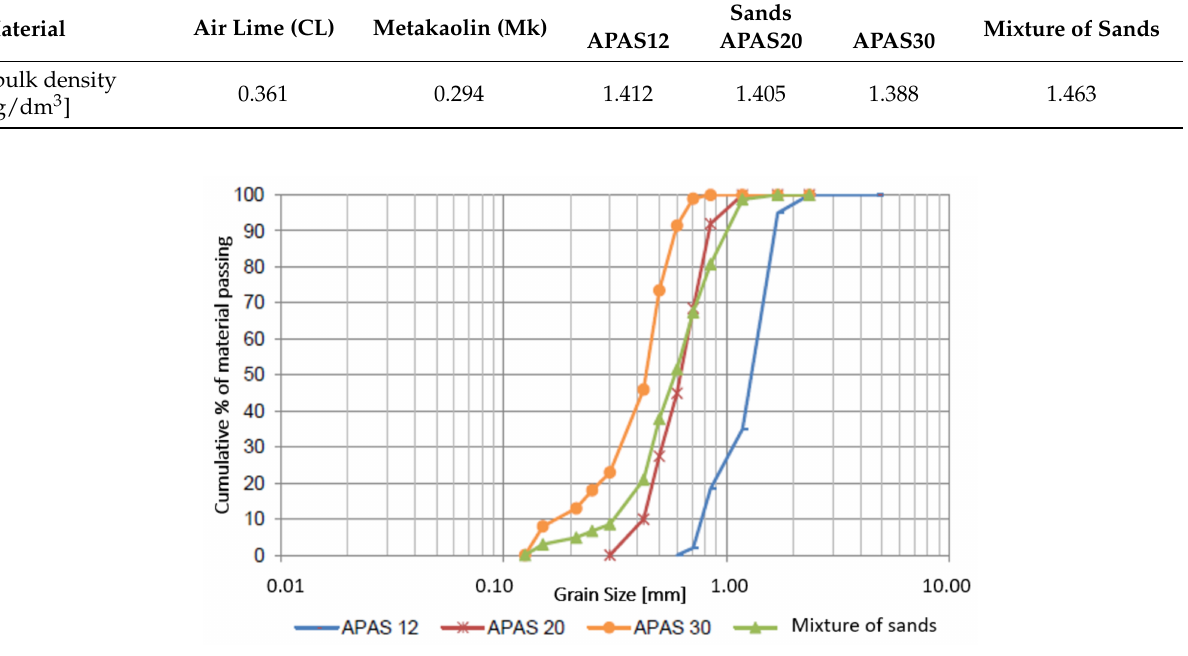
Figure 1. Particle size distribution of each sand and the mixture of the three sands.